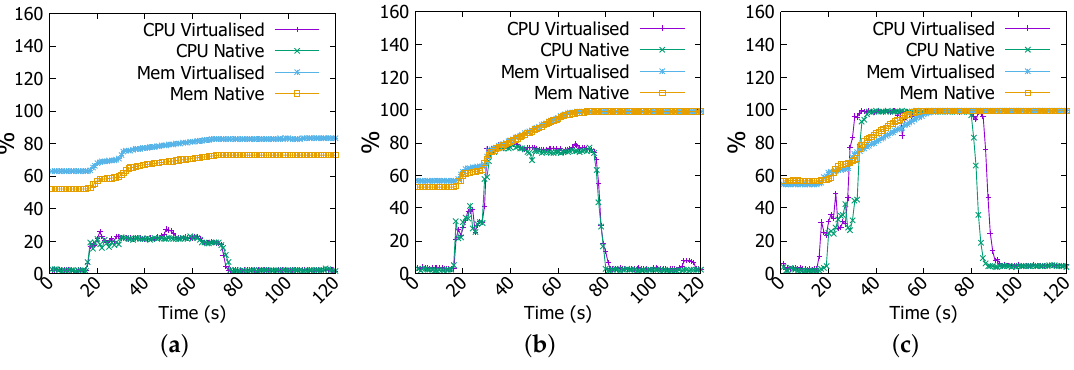
Figure 9. CPU and memory usage in WordCount job. ( a ) 1 GB file; ( b ) 4 GB file; ( c ) 6 GB file.